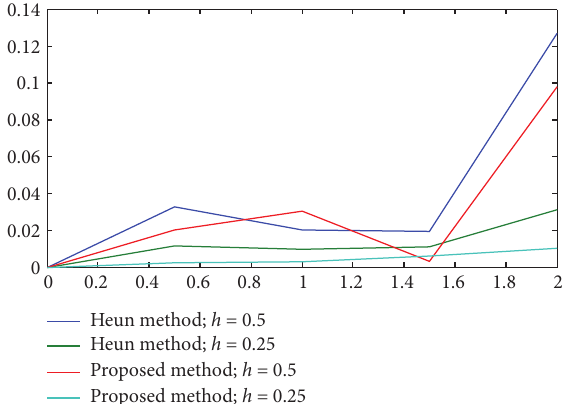
Figure 8: Errors made by the stated methods for Example 3.